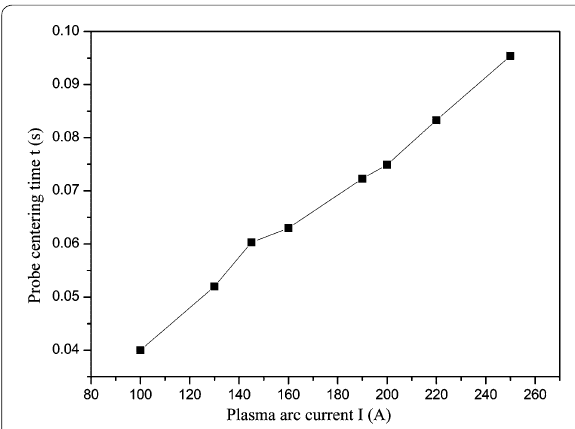
Figure 9 Change trend of the circuit current with respect to the plasma arc current